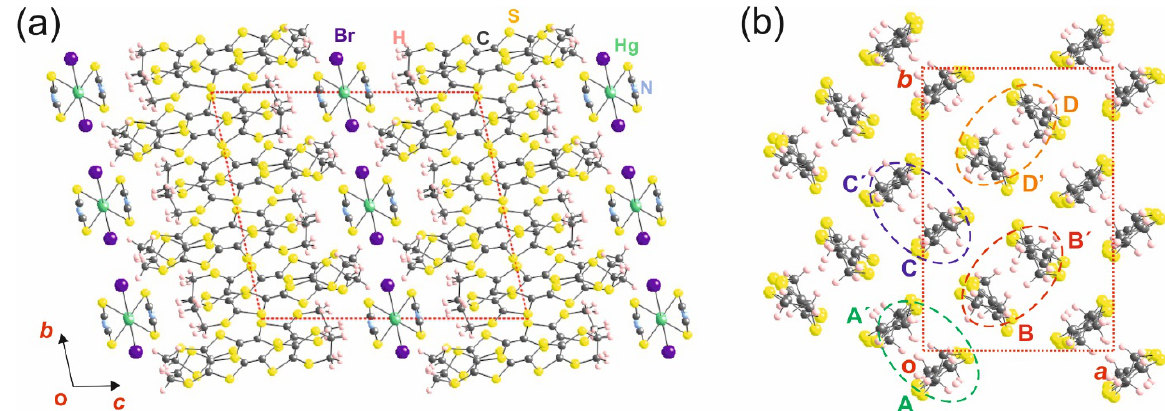
Figure 1. Low-temperature (80 K) crystal structure of κ -(BEDT-TTF) 2 Hg(SCN) 2 Br: ( a ) projection view along the a -direction; ( b ) BEDT-TTF donor layers showing the different dimers (AA’, BB’, etc.). For clarity, the disorder in half of the donor ethylidenedithio groups (i.e., those not facing the Br atoms) is not shown. The four dimers in the repeat unit of the layer are highlighted with different colors. Note that in the high-temperature structure, the repeat unit contains only two dimers, i.e., the AA’ dimer is identical to CC’ and the BB’ dimer is identical to DD’.